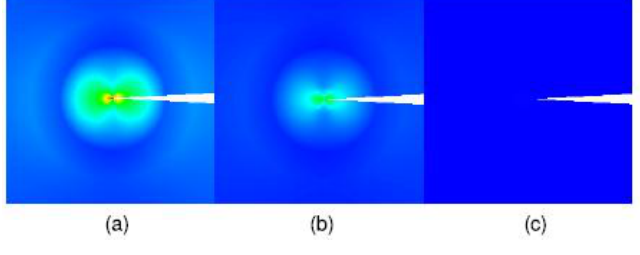
Figure 8. The Von Mises stress field around the crack tip with different applied voltages on piezoelectric patches: ( a ) 0 V, ( b ) 300 V and ( c ) 480 V